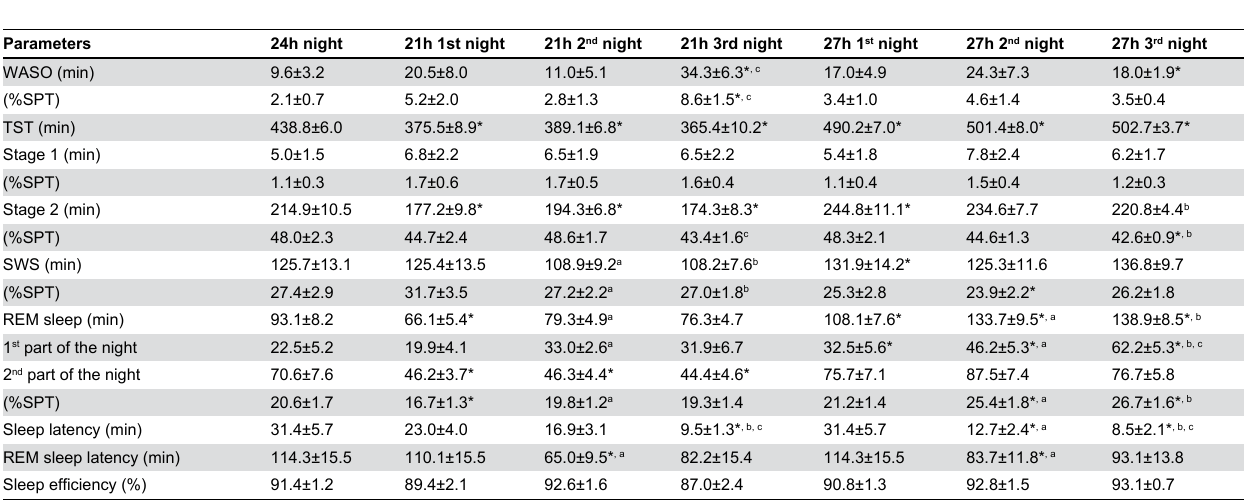
Table 2. Absolute (min) and relative (%) duration of sleep parameters during the 21h cycle and the 27h cycle compared to the control night (24h cycle). All values are means ± SEMs